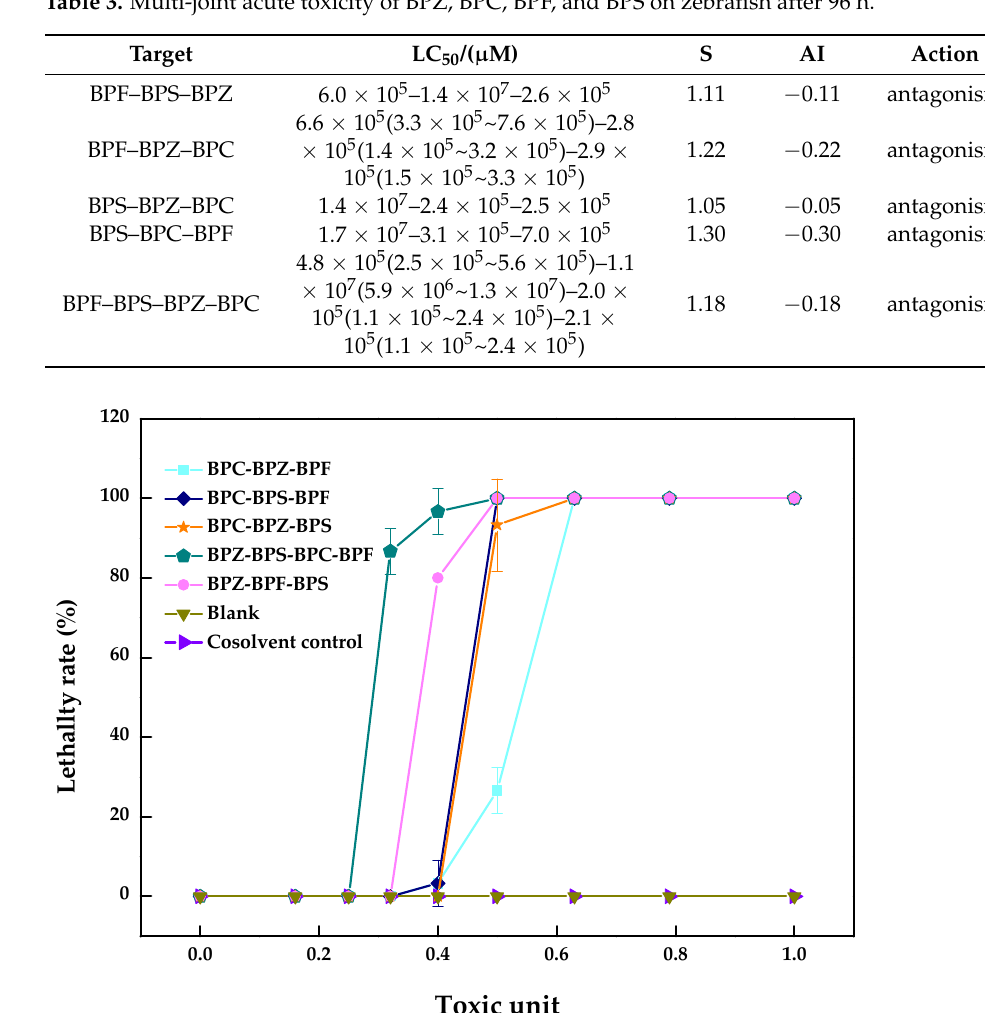
Figure 3. Multi-joint acute toxicity of BPZ, BPC, BPF, and BPS on zebrafish after 96 h (values represent mean ± S.D., sample size: 3).